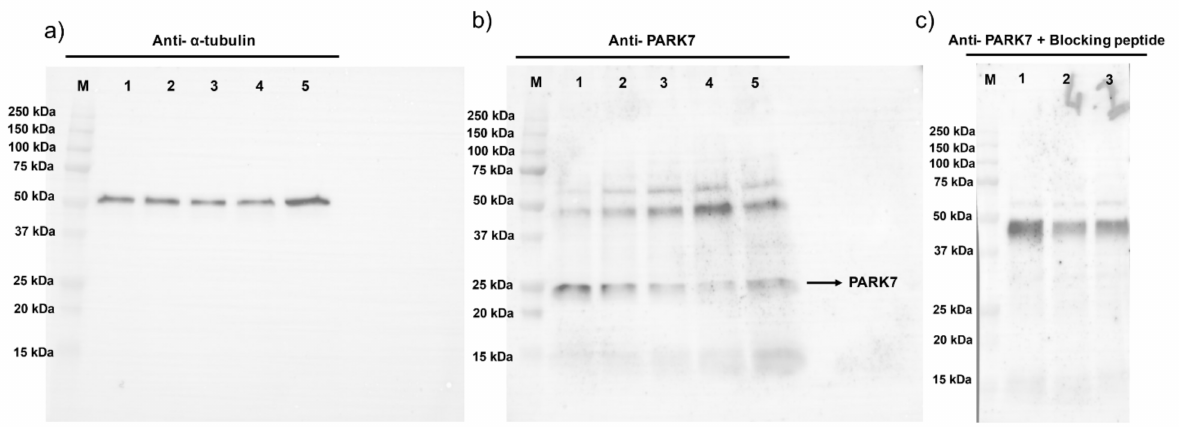
Figure 2. Representative immunoblots for α -tubulin ( a ), PARK7 ( b ), and peptide competition assay (anti-PARK7 + blocking peptide; ( c ). Lanes (M): protein ladder; (1) 0 min; (2) 120 min; (3) 240 min; (4) 250 min; and (5) 300 min of